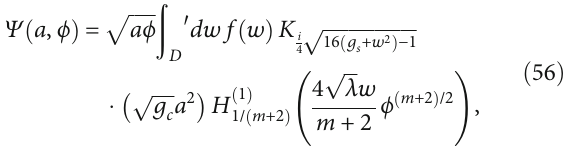
= 2 , g = 1 , λ = 1 , m = 2 , p = 2 , c s